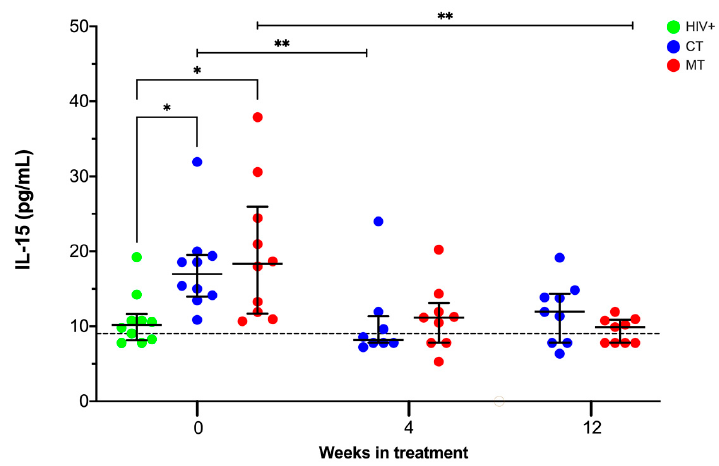
Figure 4. High circulating IL-15 levels at baseline in KS/HIV patients decreased after treatment. IL-15 levels were compared at the baseline (W 0 ) between KS/HIV and HIV+ patients and across all follow-up weeks between each group. The black dashed line represents the median value of HIV-negative men. Green dots represent HIV+ asymptomatic men, blue dots represent CT and red MT participants. Statistical comparisons were performed using Kruskal–Wallis test, * p < 0.05, ** p < 0.01.